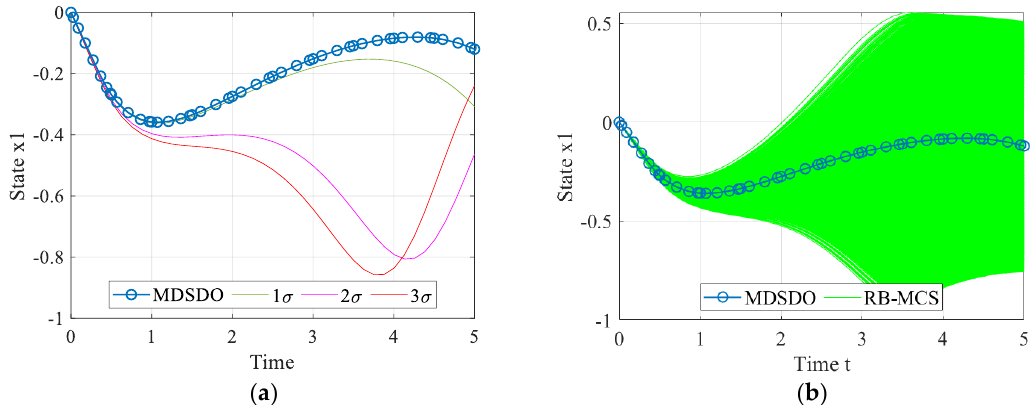
Figure 2. The influence of uncertainty on the system state trajectory. ( a ) Influence of the uncertainty samples with deviations of 1 σ , 2 σ , and 3 σ . ( b ) Influence of the MCS-based uncertainty